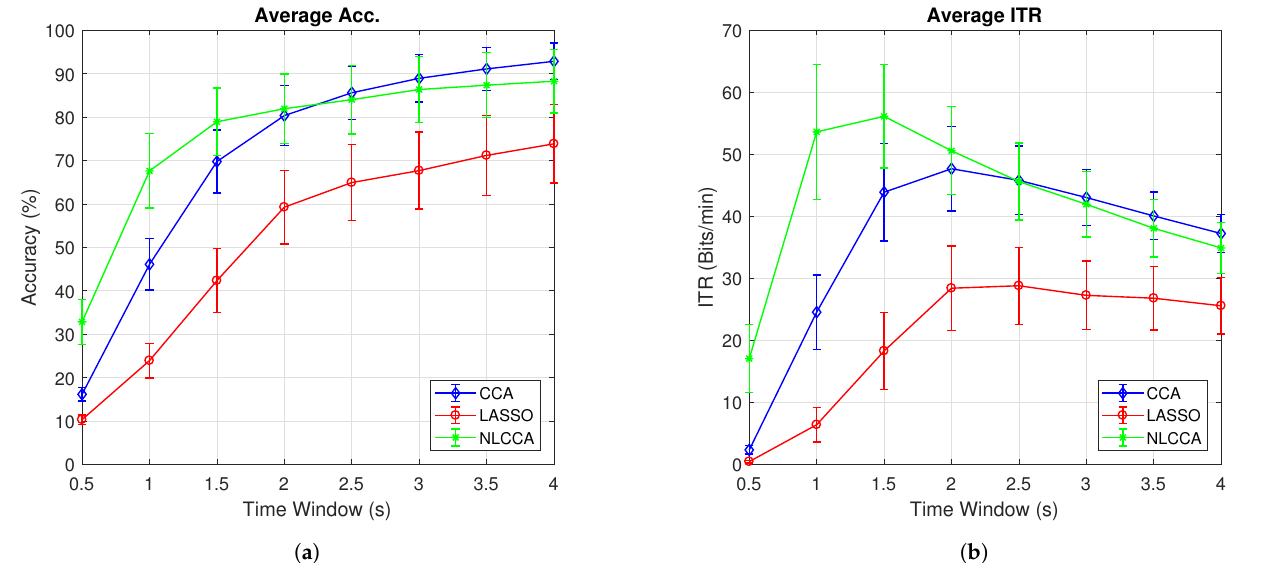
Figure 7. Comparison of ( a ) average accuracy and ( b ) average ITR between CCA, LASSO, and NLCCA.